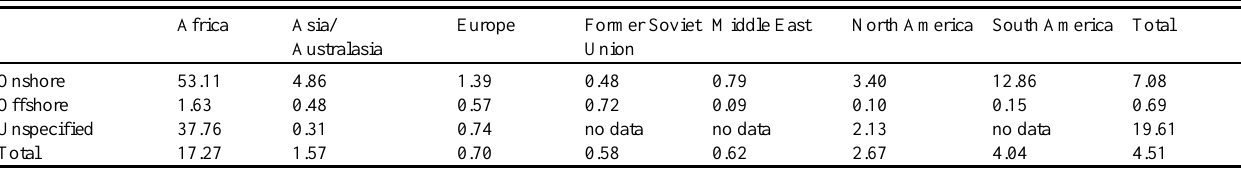
Table 6 . Quantity of oil spilled onshore and offshore per unit of hydrocarbon production (tonnes per million tonnes), by region (2010